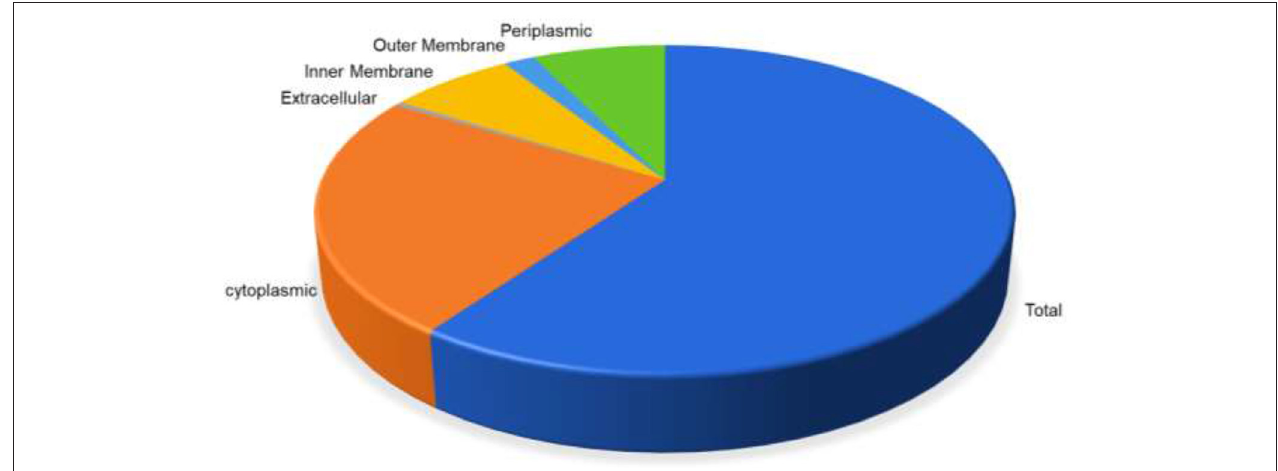
FIGURE 1 | Distribution of proteins based on the location inside the cell. Periplasmic (green) are 7.32%, outer membrane (light blue) 1.72%, inner membrane (yellow) 6.94%, extracellular (gray) 0.45%, while cytoplasmic proteins are 23.66%, respectively.